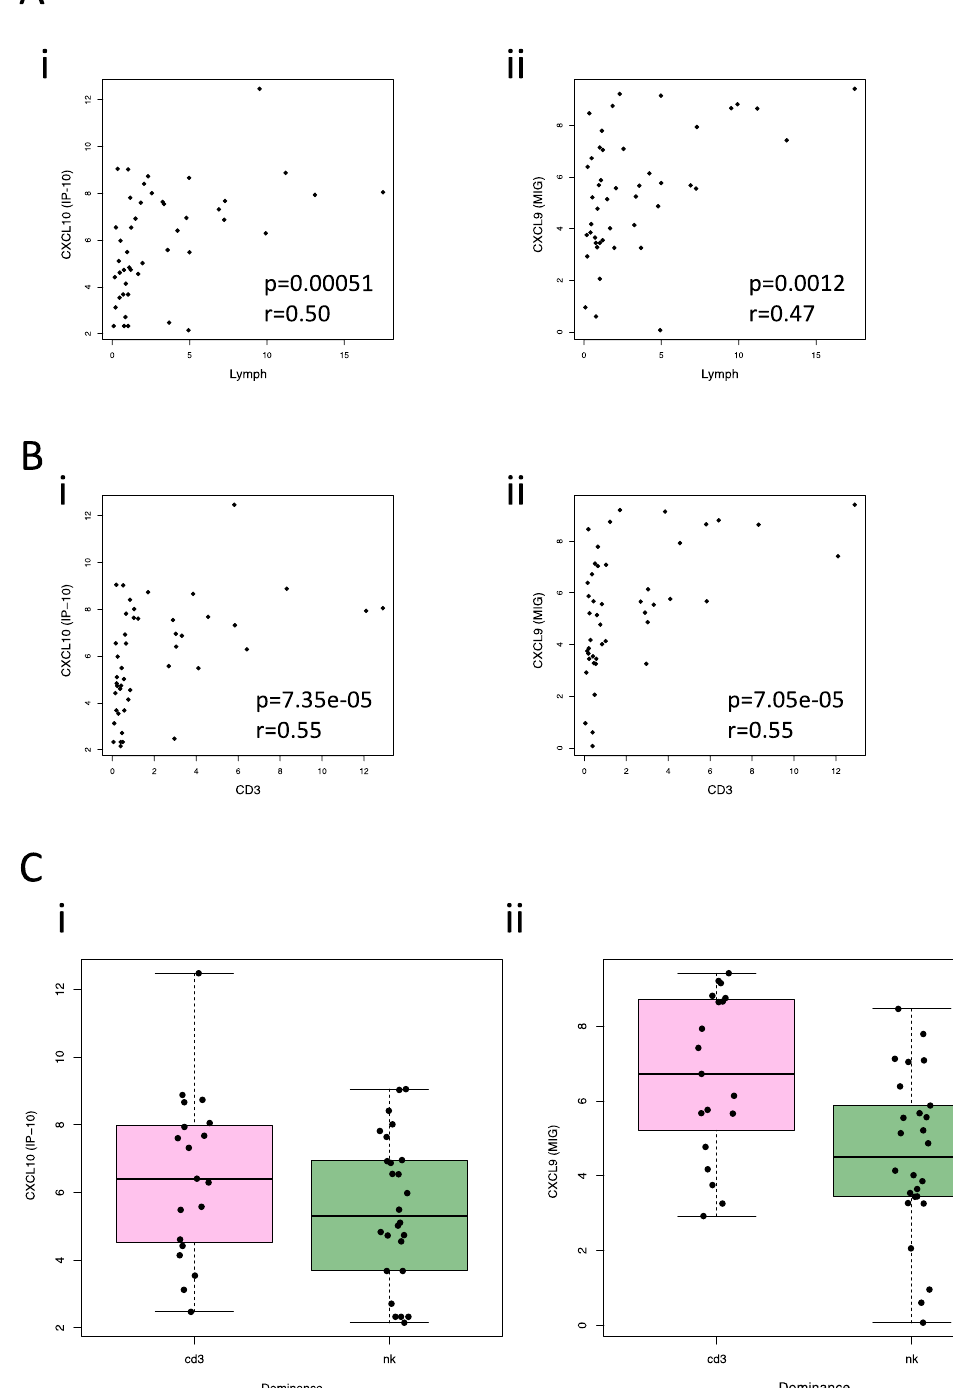
Figure 3. ( A ) Scatterplots showing Spearman’s correlation between the expression of various cytokines (CXCL10 and CXCL9) with the overall quantity of lymphocytes in the tumor samples: (i) CXCL10 vs Lymphocytes; (ii) CXCL9 vs Lymphocytes. Lymph = Lymphocytes. CXCL10 and CXCL9 showed the strongest positive correlations with the abundance of lymphocytes in the tumor. p = p -value, r = Spearman’s rho. ( B ) Scatterplots showing positive Spearman’s correlations between the expression of the cytokines and CD3 + T cell abundance out of all cells in the tumor: (i) CXCL10 vs CD3, (ii) CXCL9 vs CD3. p = p -value, r = Spearman’s rho. ( C ) Boxplots comparing the expression of (i) CXCL10 and (ii) CXCL9 with tumor immune cell dominance. CXCL9 was significantly elevated in the CD3 + T cell dominant compared to the NK cell dominant tumors ( p =